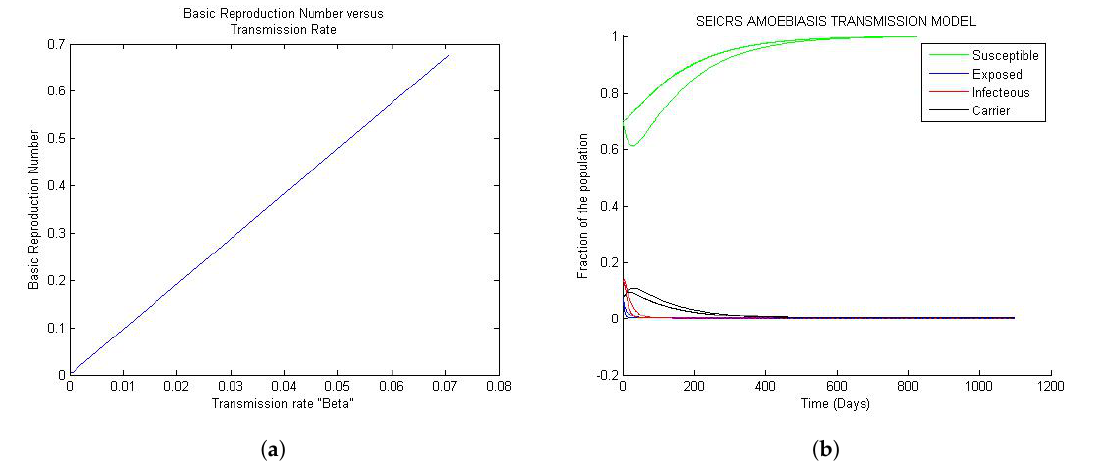
Figure 2. General trend of the model for values of R 0 very close to one: ( a ) Curve of the R 0 versus β ; ( b ) structure of the 25